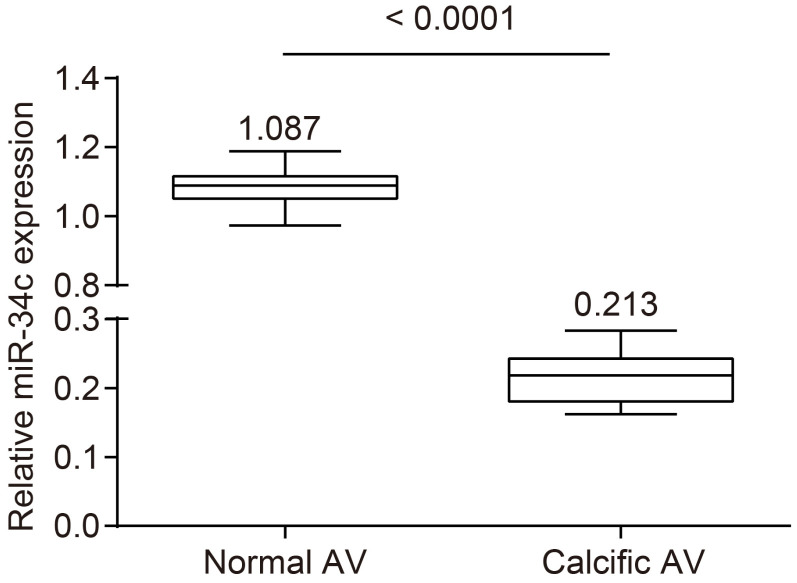
The expression of miR-34c is downregulated in calcified AV. The expression of miR-34c in tissue samples of arterial flap was determined by RT-qPCR. Data are presented as mean ± standard deviation. Differences between negative control (n = 32) and CAVD group (n = 25) are compared using the unpaired Student’s t test.